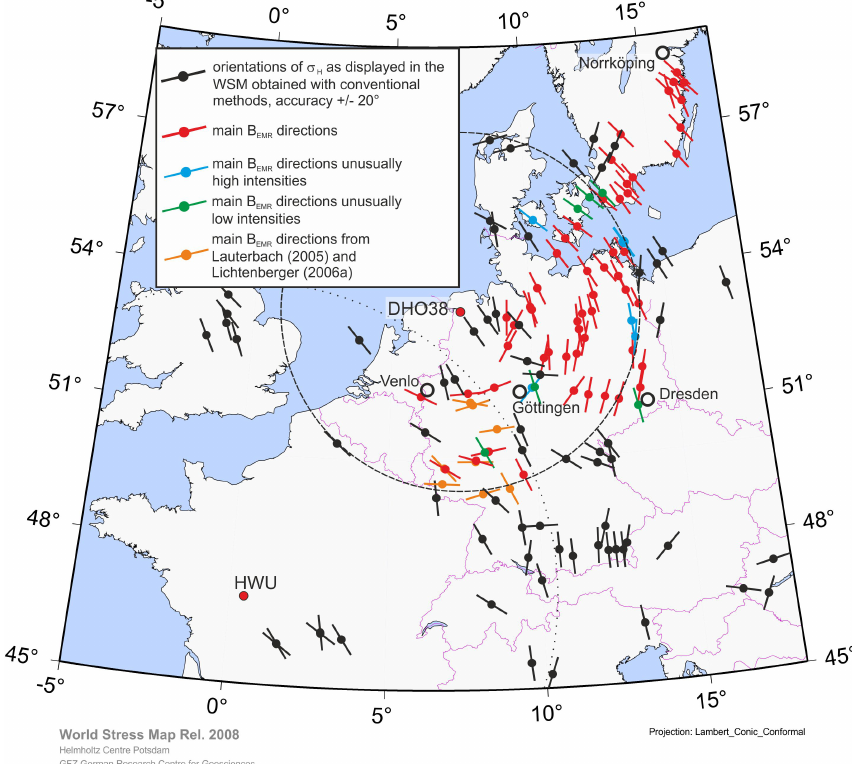
Fig. 3. Distribution of the main directions of the magnetic component of EMR ( B EMR ) of this study in comparison with σ H as published in the WSM (Heidbach et al., 2008). Red trajectories display the measured B EMR main directions with typical intensities. Blue trajectories indicate remarkably high intensities and green trajectories remarkably low intensities. Grey and black trajectories show σ H directions as displayed in the WSM. Orange trajectories show representative results of Lauterbach (2005) and Lichtenberger